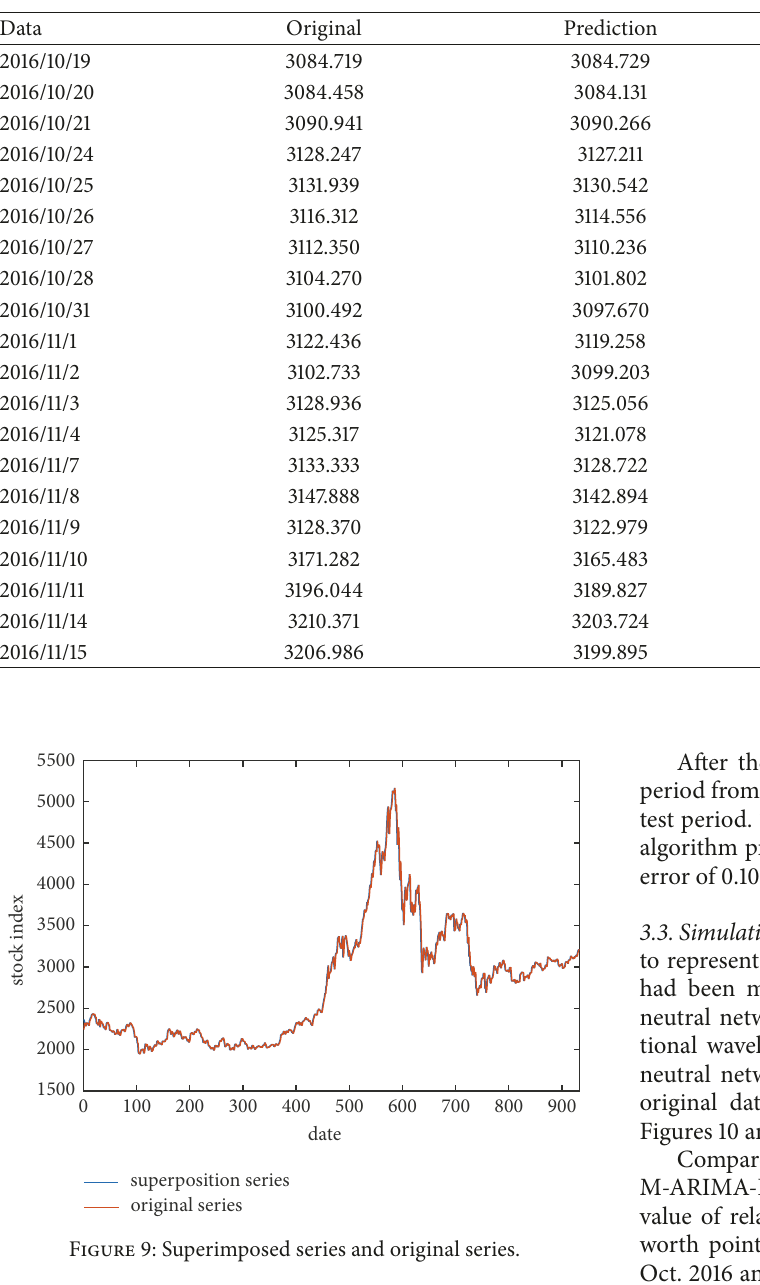
be found that the error caused by the superposition process is small, as shown in Table 2. Therefore, the superposition rule is